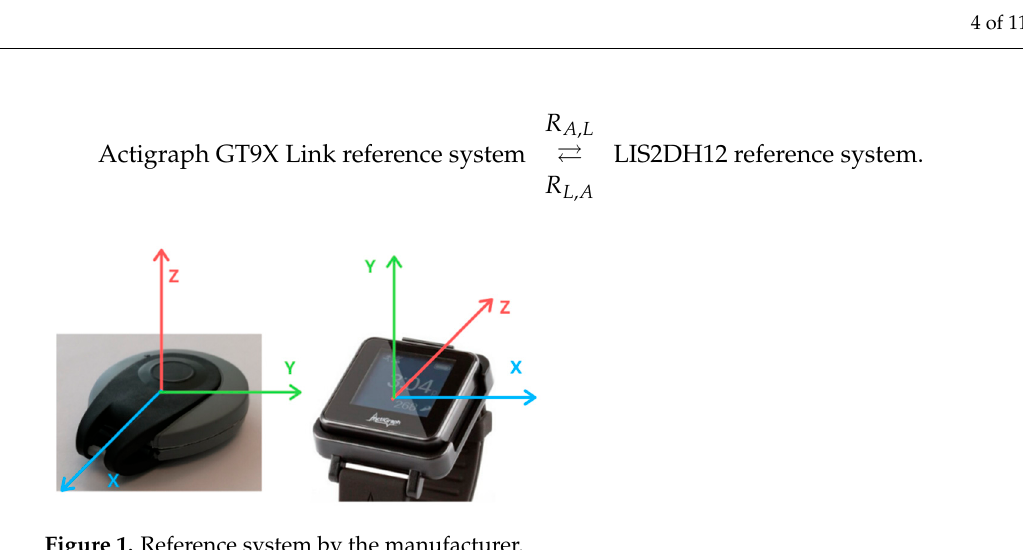
Figure 1. Reference system by the manufacturer.